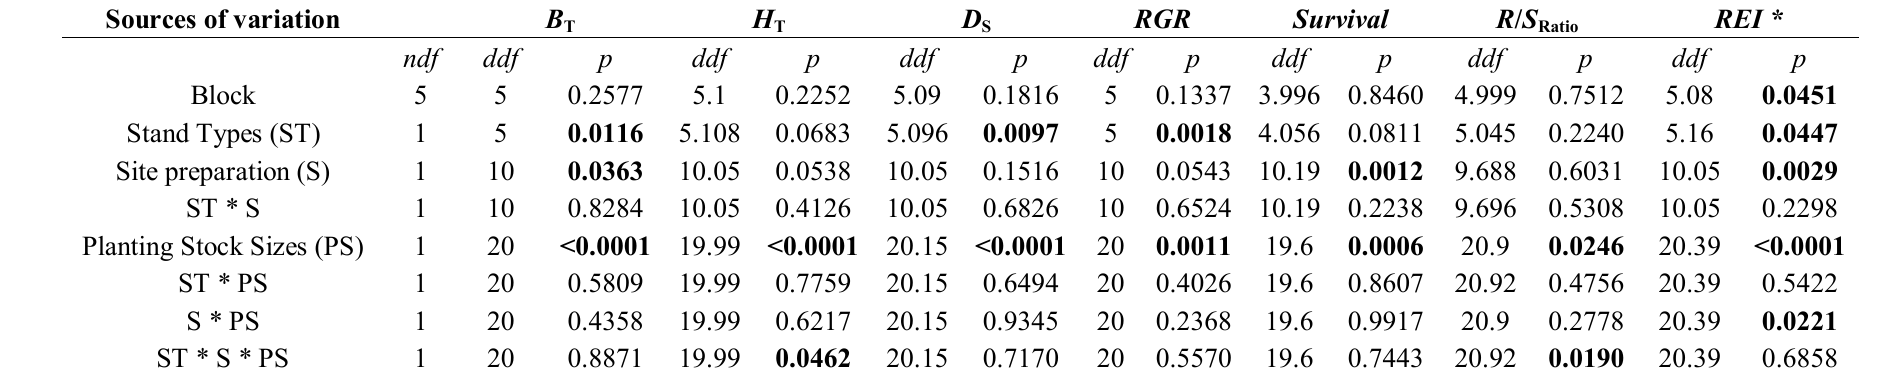
Table 1. Summary of analysis of variance (ANOVA) results for total dry biomass ( B relative growth rate ( RGR ), survival, root to shoot ratio ( R / S plantation in lichen woodlands and black spruce feather-moss stands, in scarified or unscarified plots and with smaller (126-25) or larger (67-50) containerized stock